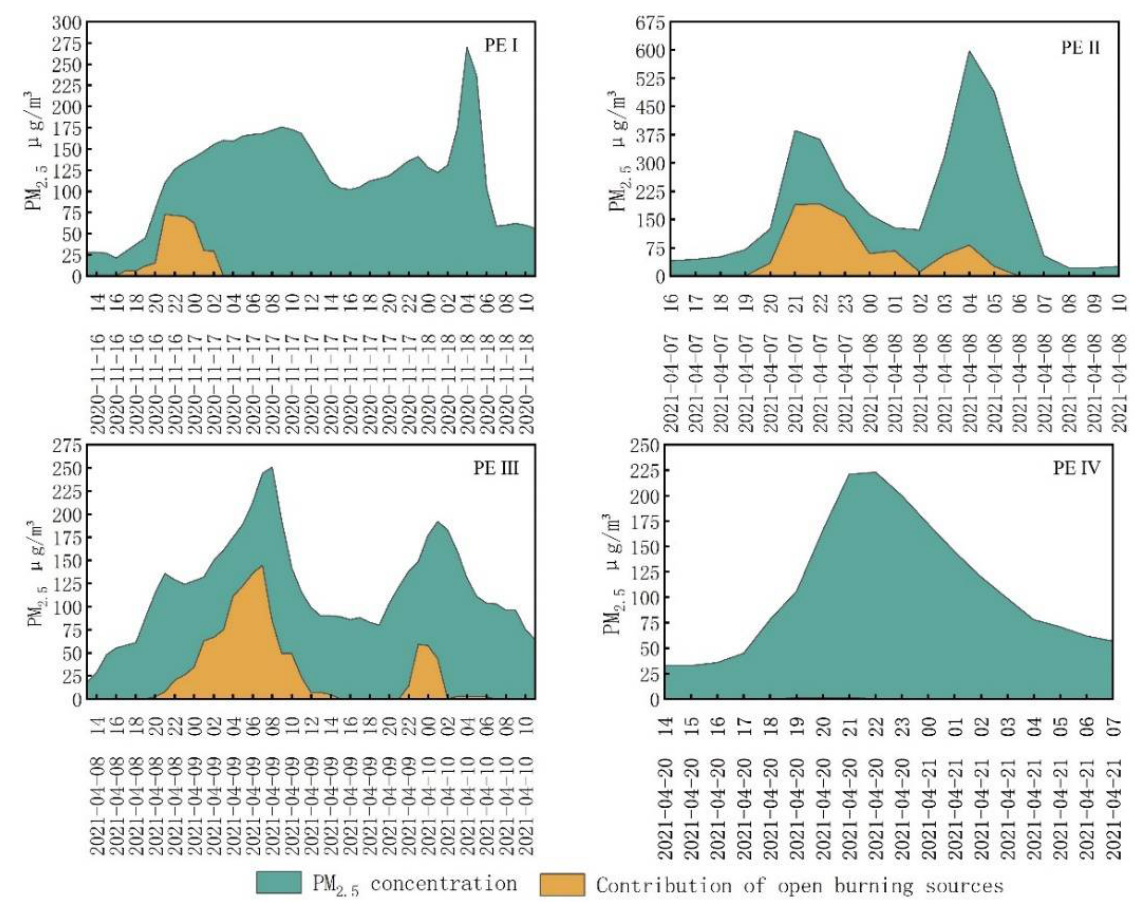
Figure 10. The contribution from straw open burning sources to urban PM 2.5 levels. It is interesting that the contribution from SOB during PE IV was low, despite the burning area of the identified SOB fire spots being nearly twice that of PE I. The total contri- bution from SOB sources during PE IV was 4.9 µ g m − 3 , which accounted for 0.31% of the urban cumulative PM 2.5 concentration. This is because of the higher PBLH on the